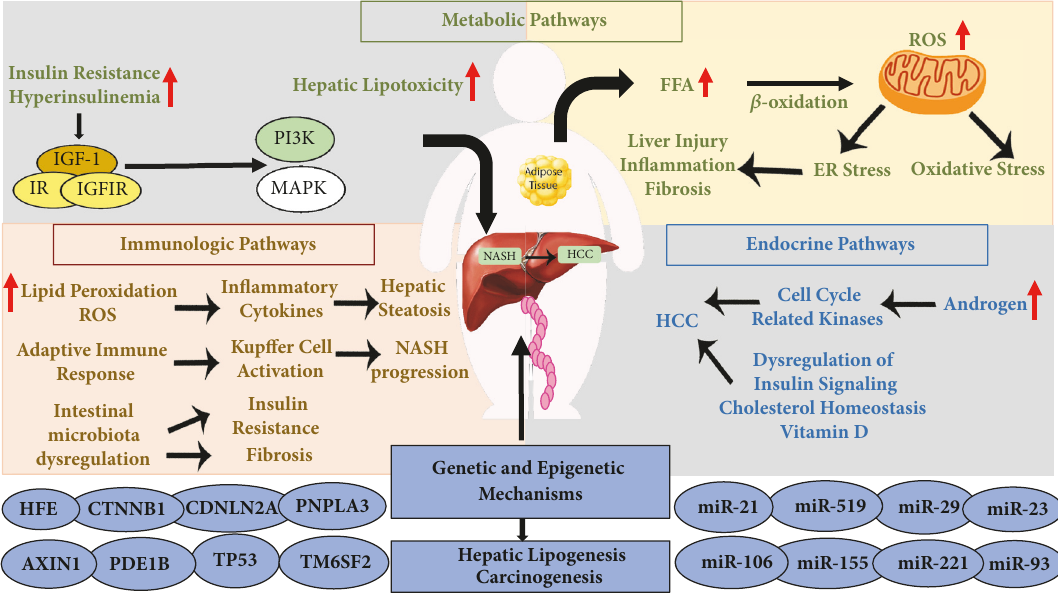
Figure 2: The proposed mechanisms in NASH-related HCC